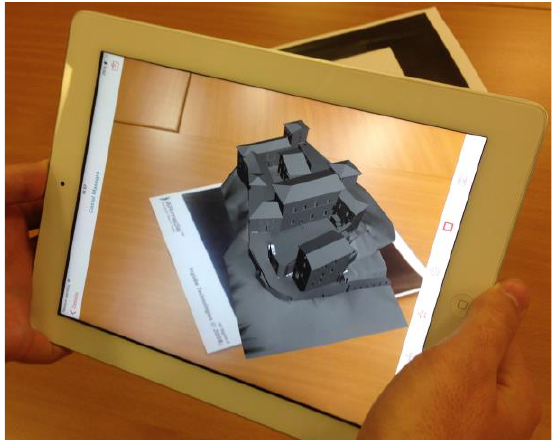
Fig. 10. A 3D model without information can be imported in augmented reality applications.